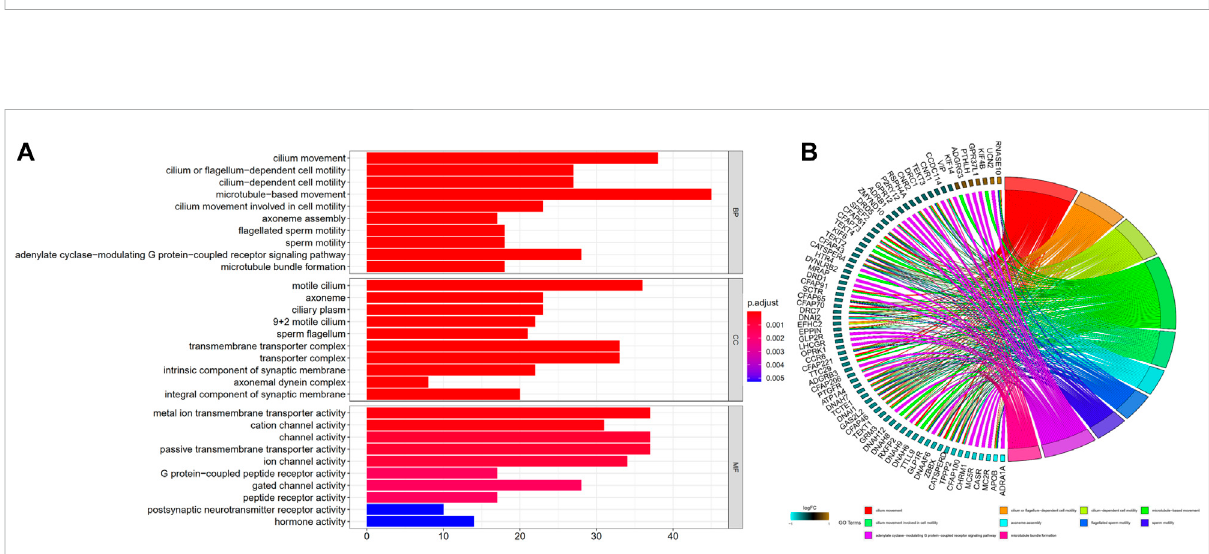
FIGURE 5 GOfunctionalenrichments. (A) Thetop10GOfunctionalenrichmentsincludedBP,CC,andMF.Thesmallertheadjusted p ,themoresigni fi cant theenrichment. (B) GOBPchordplot.GOtermsrepresentthetop10GOBPfunctionalenrichments,andgenenameswiththeconnectionrepresent their enriched genes. BP, biological process; CC, cellular component; MF, molecular